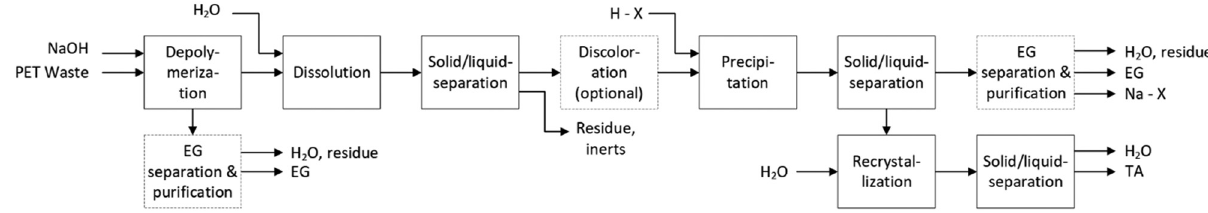
Figure 12: Block diagram of the continuous back - to - monomer